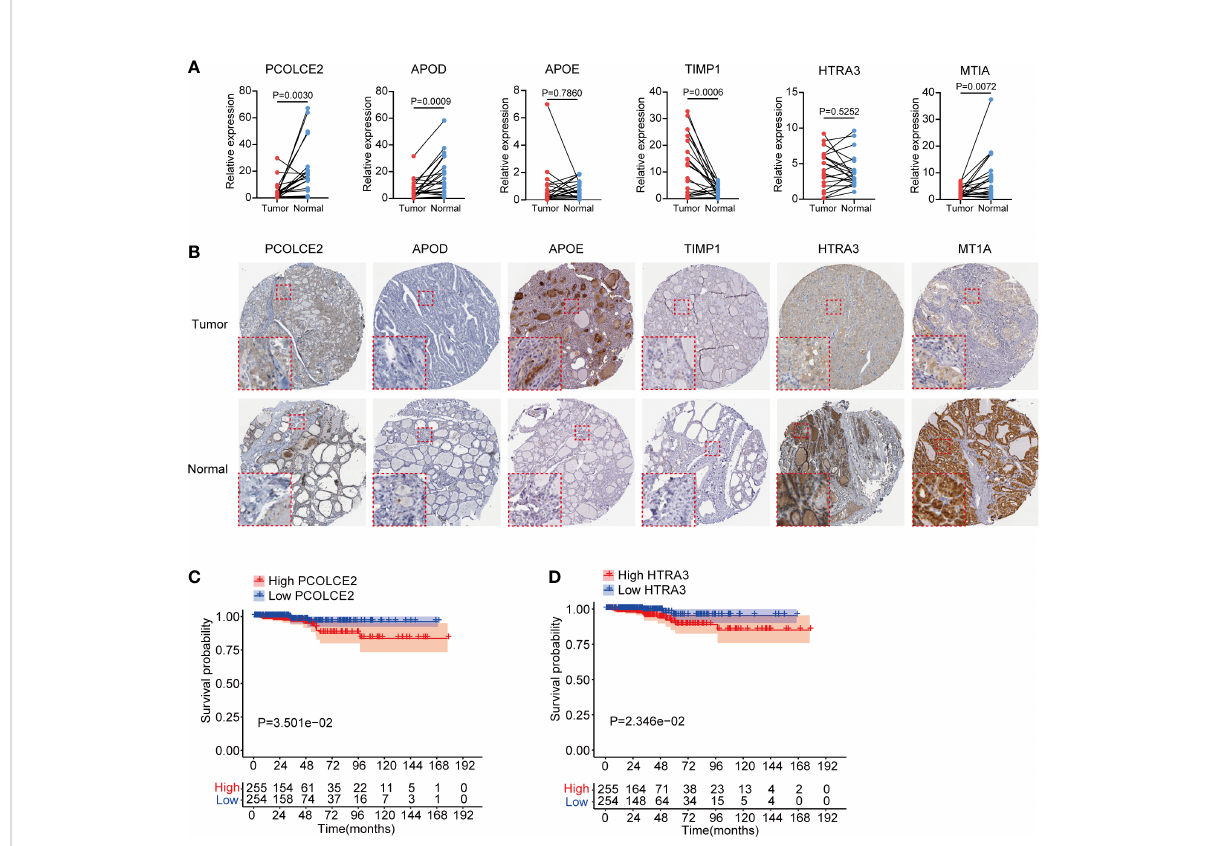
FIGURE 7 Expression validation and survival analysis of 6 key fi broblast related genes in thyroid cancer. (A) Transcriptional expression of PCOLCE2, APOD, APOE, TIMP1, HTRA3 and MT1A in 20 pairs clinical PTC and normal thyroid tissues. (B) Protein expression of PCOLCE2, APOD, APOE, TIMP1, HTRA3 and MT1A in normal and tumor thyroid tissues from Human Protein Atlas. (C, D) Kaplan – Meier plots showed that high expression of PCOLCE2 and HTRA3 were associated with poor overall survival probability for thyroid cancer